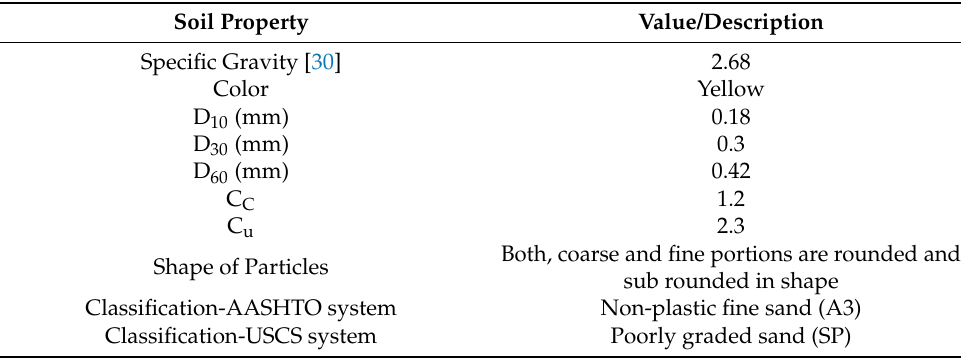
Table 1. Summary of the physical properties and classification of the dune sand.